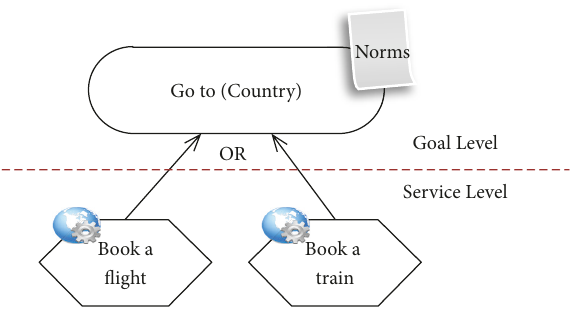
Figure 2: Services that could be chosen for satisfying the goal.